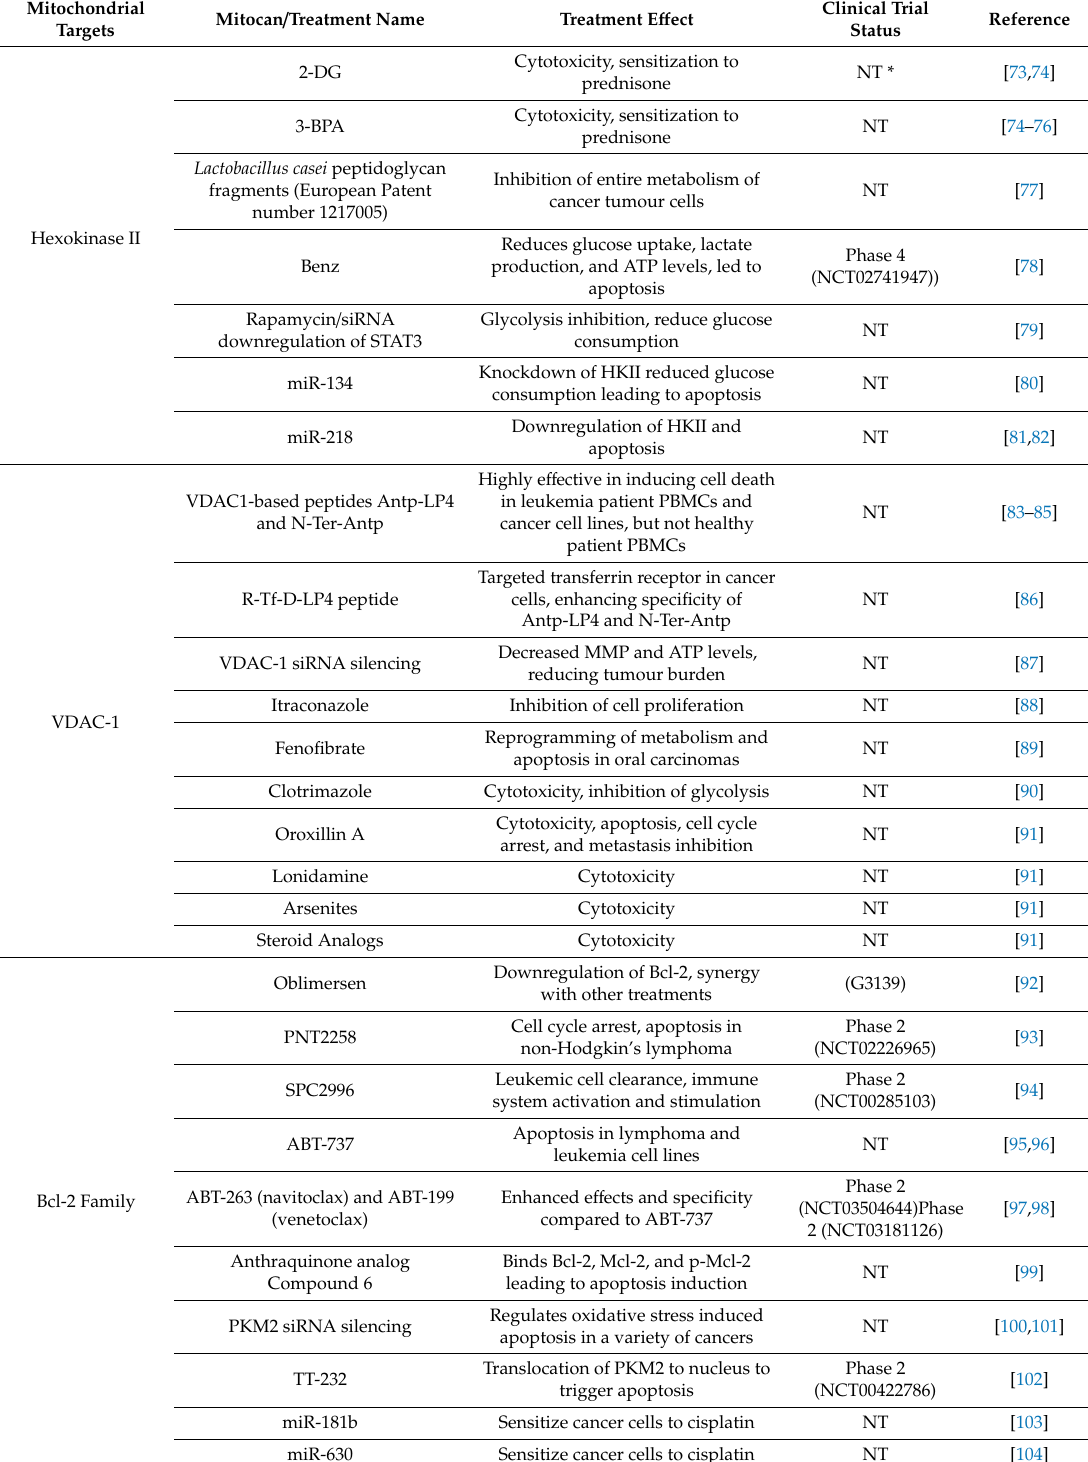
Table 1. Mitocan treatments, targets, and treatment e ff ects. VDAC1—voltage-dependent anion channel 1; 2-DG—2-deoxy-D-glucose; 3-BPA—3-bromopyruvate; Benz—benserazide; STAT3—signal transducer and activator of transcription 3; HK—hexokinases; PBMCs—peripheral blood mononuclear cells; MMP—mitochondrial membrane potential; PKM2—pyruvate kinase M2